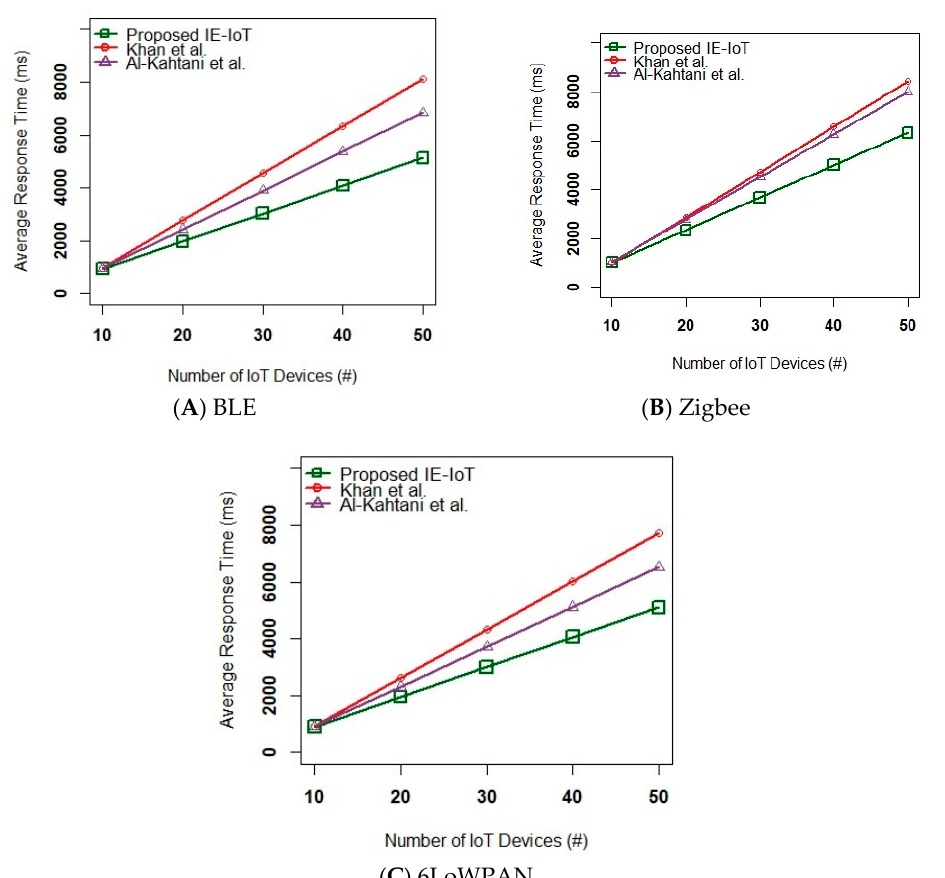
Figure 8. Average Response Time 〈ms〉 versus Number of IoT Nodes. Figure 8. Average Response Time (cid:104) ms (cid:105) versus Number of IoT Nodes